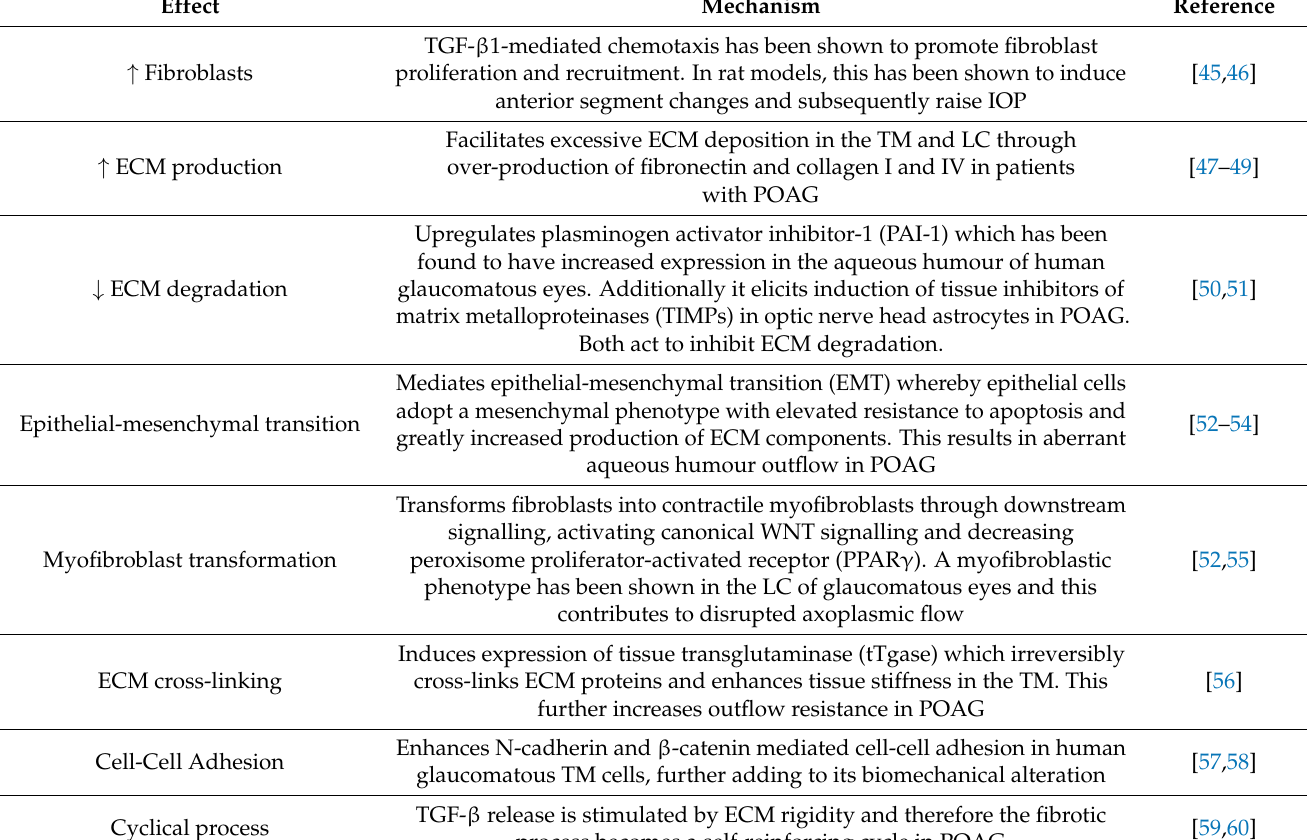
Table 1. Role of TGF- β in